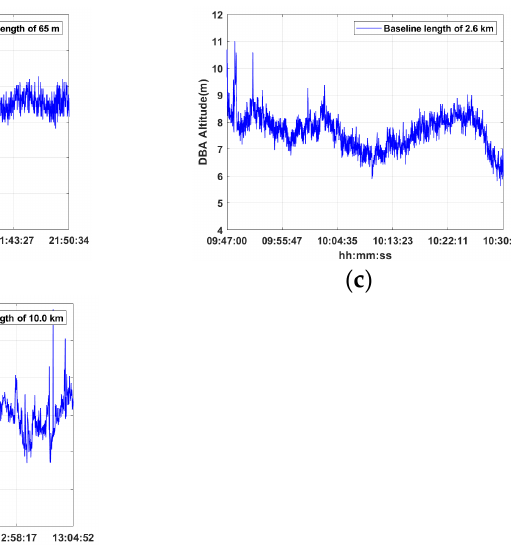
Figure 3. Five mobile station locations at different baseline lengths for altitude accuracy evaluation of the outdoor DBA systems.